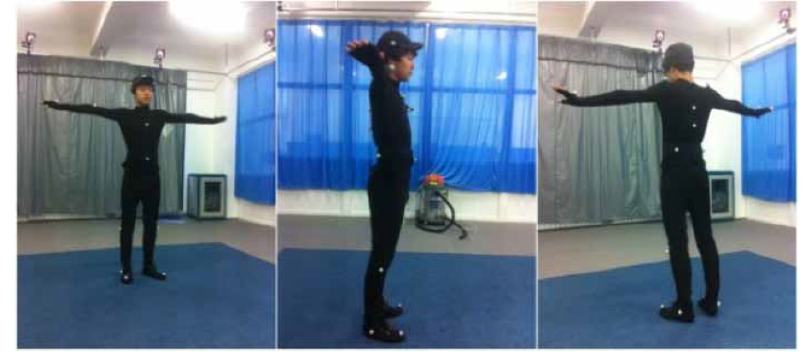
Fig. 3 An actor in a monochrome costume with a